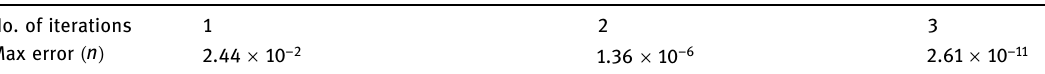
Table 1: Maximum errors of Example 1